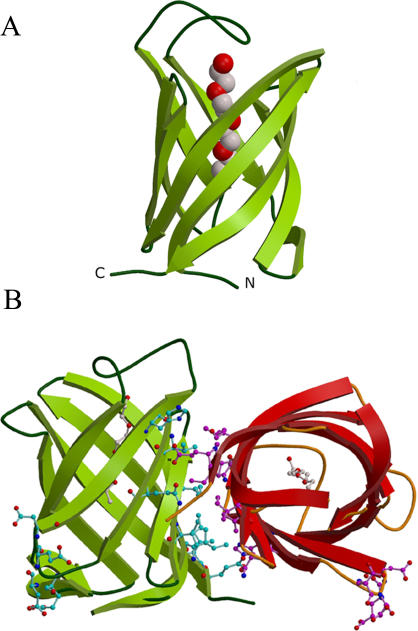
Overall Structure of GrlR with Bound Ligand(A) Ribbon diagram of monomer. The β-strands and the random coils/turns are depicted in light and dark green colors, respectively. The Triton-X100 molecule is bound in the hydrophobic pore of the eight-stranded β-barrel. The CPK model of the ligand is shown with oxygen and carbon atoms colored in red and grey, respectively.(B) Ribbon diagram of the dimer. Monomer A is shown in red, monomer B in green. The dimeric interface residues, surface-exposed residues (EDED motif), and the ligand from both monomers are shown in ball and stick representation. This figure was drawn using Molscript and Raster3D [42,43].